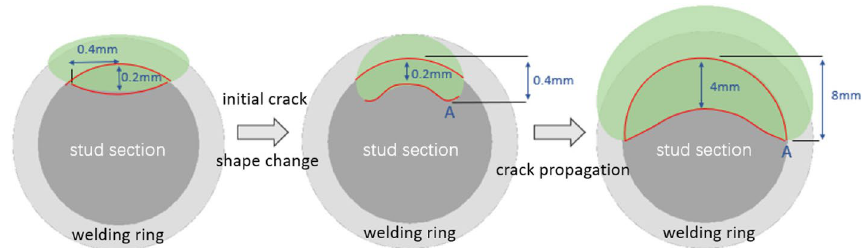
Fig. 13 Prefabricated initial crack and critical fracture crack